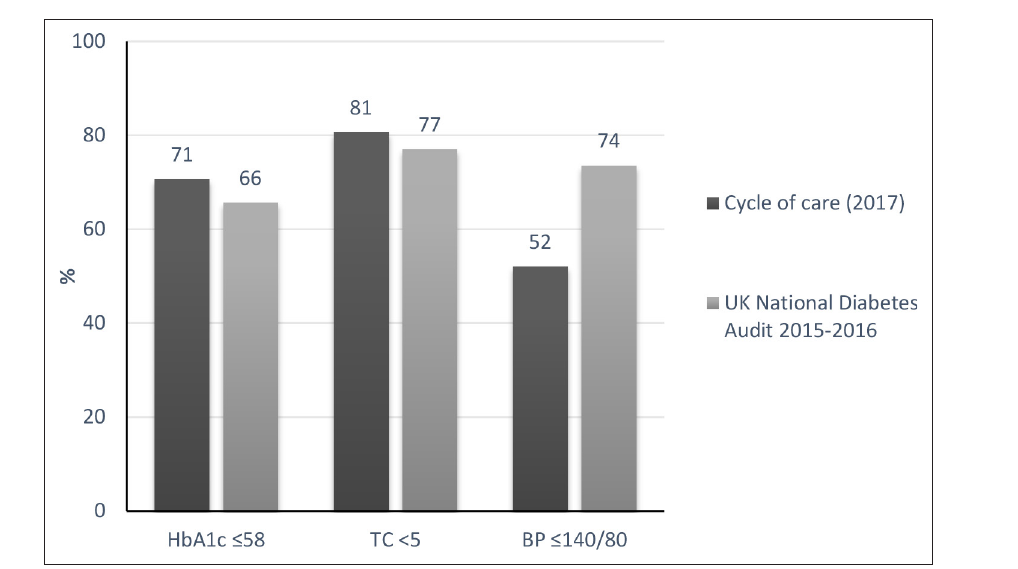
Figure 2 Comparison of percentage of patients achieving treatment targets in 2017 cycle- of- care sample compared with the UK National Diabetes Audit (2015–2016). BP = blood pressure. HbA1c = glycosylated haemoglobin. TC = total